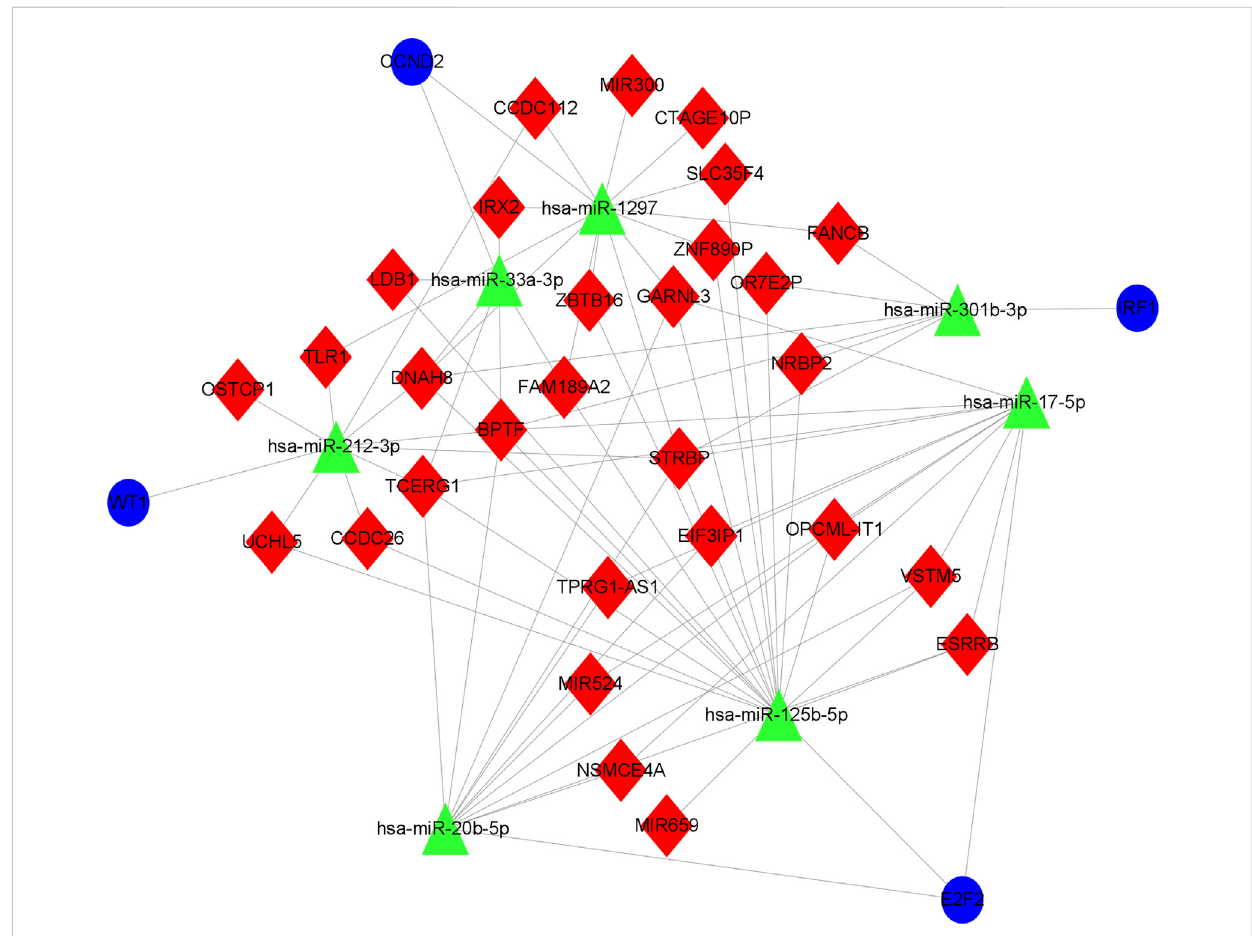
FIGURE 13 Core ceRNA sub-network diagram of key genes. The construction of the ceRNA network included 29 DElncRNA, 7 predicted miRNA and 4 DEmRNA. Blue circles, green triangles and red diamonds represent DEmRNA, miRNA and DElncRNA, respectively. DElncRNA: differentially expressed lncRNA; DEmRNA: differentially expressed mRNA; miRNA: